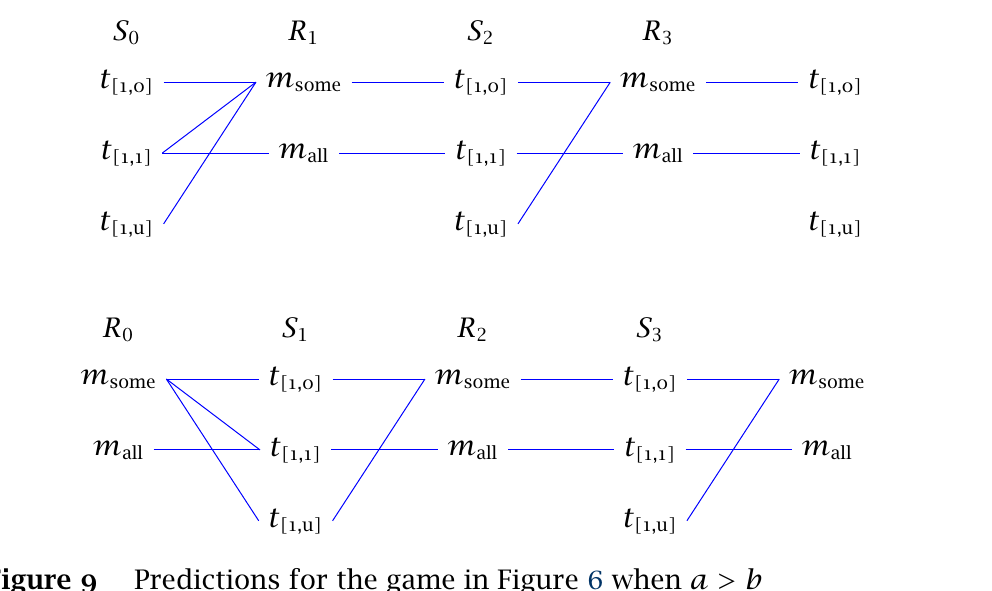
Figure 9 Predictions for the game in Figure 6 when a > b Interpretation of fixed-point behavior. When it comes to matching